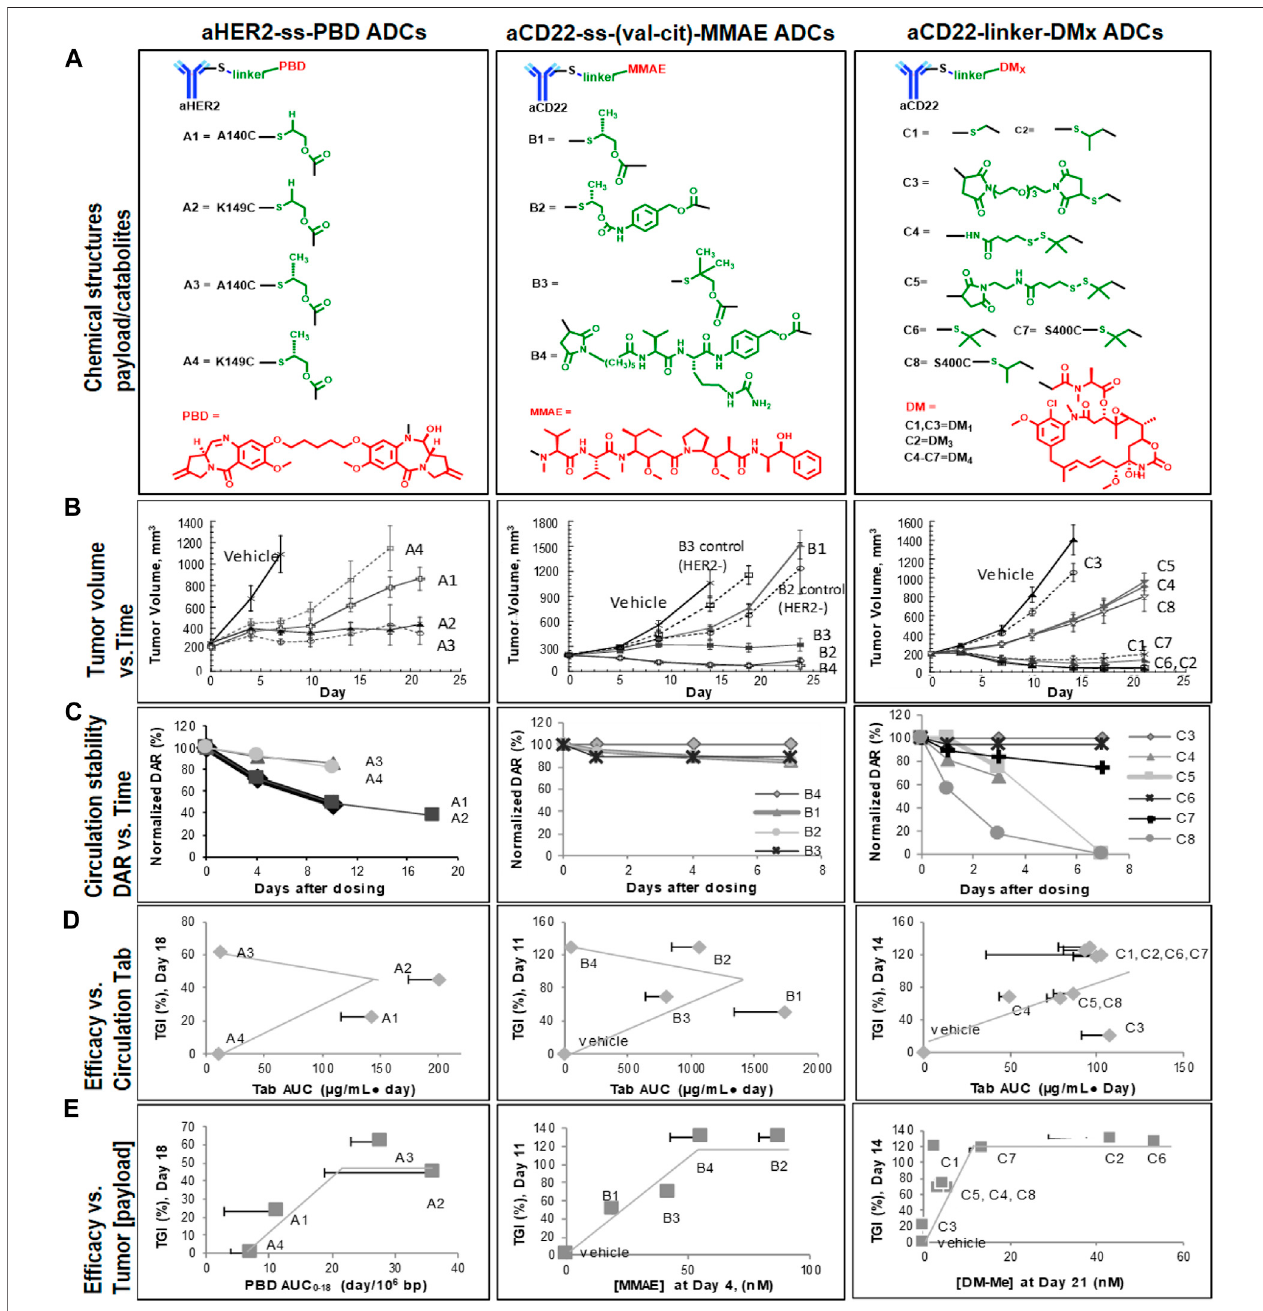
FIGURE 2 | Case studies of PBD-, MMAE-, and DMx-ADCs in mice bearing human HER2-expressing Fo5 or human CD22-expressing BJAB. Luc xenografts ( n (cid:1) 8, IV, A1/A2: 4 mg/kg; A3/A4: 0.4 mg/kg; B1-B3: 20 mg/kg; B4: 1 mg/kg; C1-C8: 50 μ g/m 2 or 1 – 1.6 mg/kg). (A) Chemical structures of TDCs and payloads or catabolites, (B) Ef fi cacy pro fi les, (C) Normalized DAR and time pro fi les in plasma, (D) Correlation X-Y plots of plasma total antibody AUC exposures (of PBD, MMAE, or DMxconjugates)withTGIrel,and (E) CorrelationX-Yplotsoftumorpayload/cataboliteexposures(PBD,MMAE,orDMx)withTGIrel.Note:theTGIrelforPBDADCs were calculated against the least active ADC A4 as apposite to the vehicle group for MMAE and DMx ADCs due to rapid tumor growth and early termination on day 7. Adapted with permission from (Zhang et al., 2019). Copyright 2019 American Society for Pharmacology and Experimental Therapeutics.